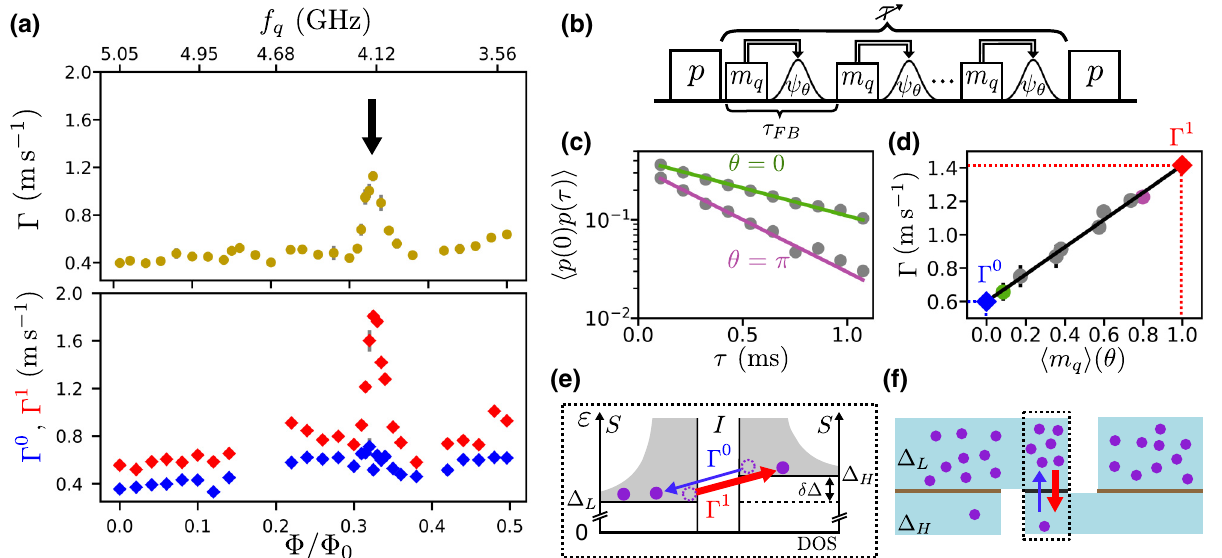
FIG. 2. (a) Upper: the flux dependence of the parity-switching rate (cid:4) ≈ 0.5 ((cid:4) 0 + (cid:4) 1 ) , measured by fitting power spectral densities of jump traces of parity ( (cid:4) 0 : = (cid:4) 0 → 0 + (cid:4) 0 → 1 , (cid:4) 1 : = (cid:4) 1 → 1 + (cid:4) 1 → 0 ). The parity is measured by a Ramsey-like sequence that maps the parity onto the state of the qubit [15,19]. Lower: the flux dependence of the parity-switching rate when the qubit starts in the ground (blue) or excited (red) state, measured by the protocol described in (b). (b) The pulse sequence for measurement of (cid:4) 0 , (cid:4) 1 . Two measurements of the parity ( p ) are separated by a variable delay of length τ . For the duration of the delay, the qubit state is repeatedly measured ( m q , 4 μ s), followed by preparation of a superposition with polarization angle θ ( ψ(θ )), with feedback block repetition time τ FB = 5.376 μ s. (c) The decay of the autocorrelation of the parity (cid:9) p ( 0 ) p (τ) (cid:5) for polarization angles θ = 0 (green) and θ = π (pink) as a function of the delay τ between parity measurements ( (cid:5)/(cid:5) 0 = 0.335). The parity autocorrelation function (cid:9) p ( 0 ) p (τ) (cid:5) decays at the rate 2 (cid:4) , which depends on the θ -dependent time the qubit spends in | 0 (cid:5) or | 1 (cid:5) . (d) The measured parity-switching rate = 0.335 ) (dots) as a function of the average measurement of the qubit state during τ (cid:9) m (cid:5) . The qubit-state-conditional parity- (cid:4)((cid:5)/(cid:5) 0 q switching rates (cid:4) 0 and (cid:4) 1 (blue and red diamonds) are determined by extrapolation of a linear fit. (e) A schematic depicting NUPS in and (cid:4) 1 → 0 are strongly enhanced by the divergent which the superconducting gap of the films differs by δ(cid:2) ≈ hf q . At this flux, (cid:4) 0 → 1 N N densities of states on both sides of the JJ. (cid:4) 0 is lower than (cid:4) 1 due to fewer QPs available for tunneling [Fig. 2(f)]. (f) A cross-section sketch of the device as in Fig. 1(b). Away from the JJ, QPs may tunnel between the two films over a very large contact area. QPs are shown predominantly in the low-gap film, illustrating the QP trapping effect, to which we attribute the rise in (cid:4) 1 but not (cid:4) 0 observed in the lower panel of